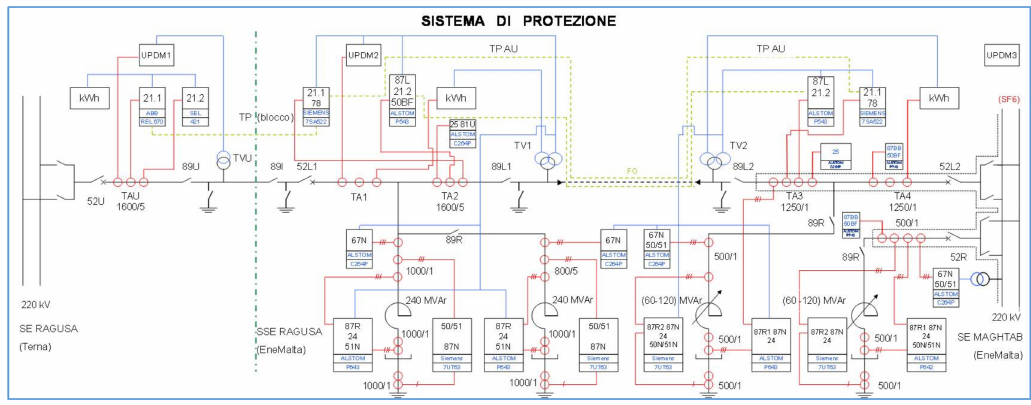
Figure 1. Single line diagram and protection devices of the 220 kV connection